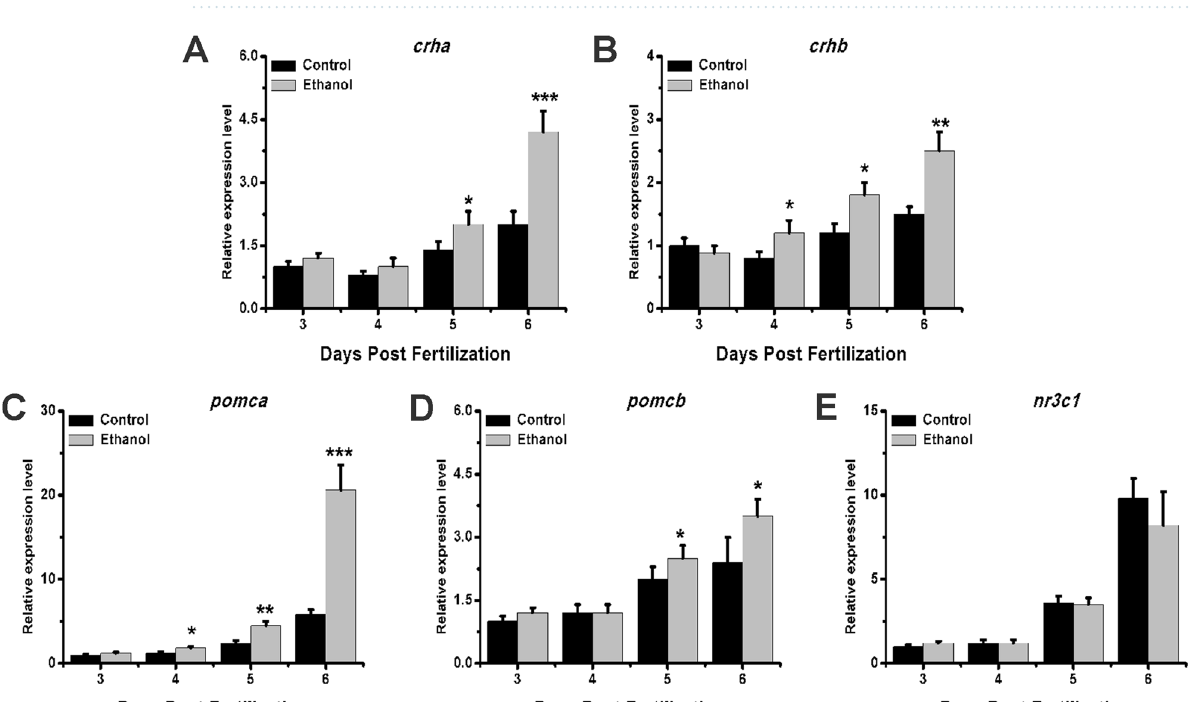
Figure 3. HPA axis gene expression patterns in zebrafish larvae after ethanol exposure. Samples were taken at 3, 4, 5, and 6 dpf. The expression patterns of (A) crha , (B) crhb , (C) pomca , (D) pomcb , and (E) gr . Three independent experiments were conducted. Student’s t-test was performed. *p < 0.05; **p < 0.01; ***p <